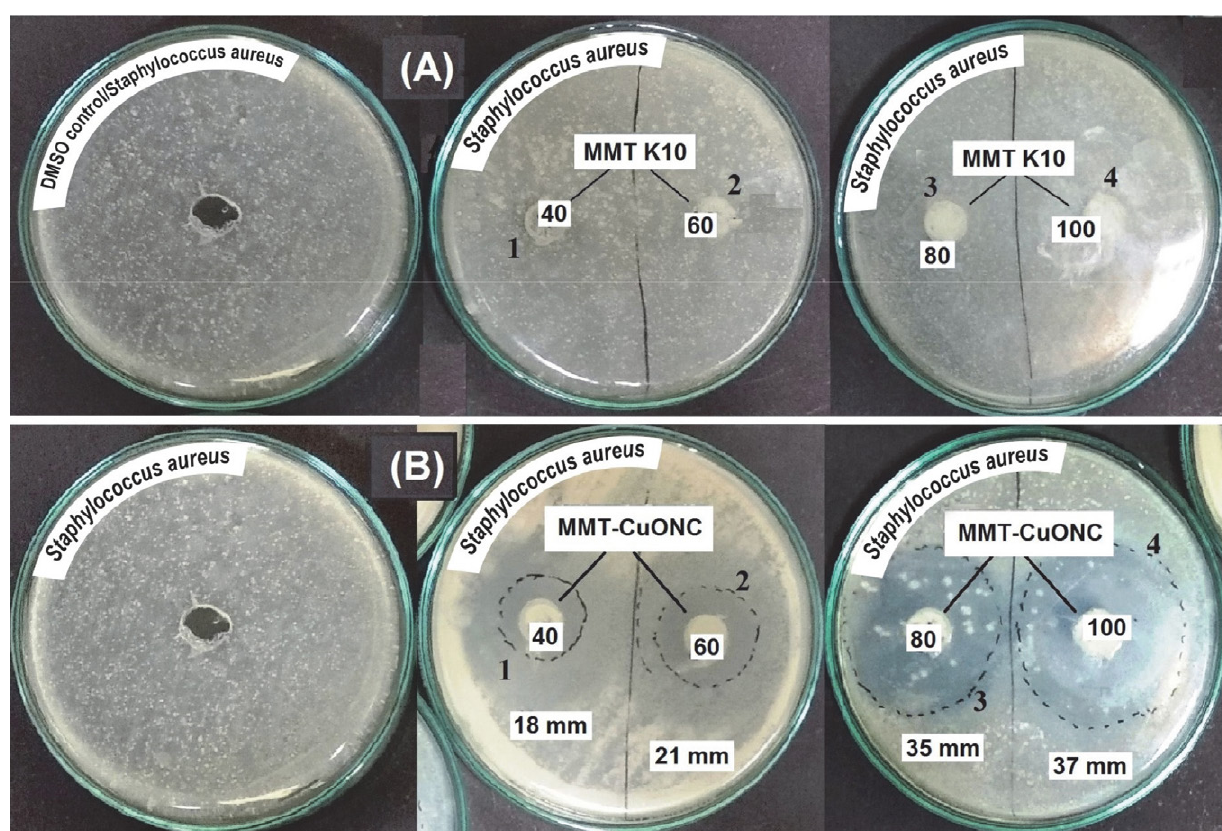
Figure 7: Zone of inhibition of MMT K10 (A) and synthesized MMT supported copper oxide nanoparticles (B) against Staphylococcus aureus (Gram positive) at different concentrations (40, 60, 80, 100